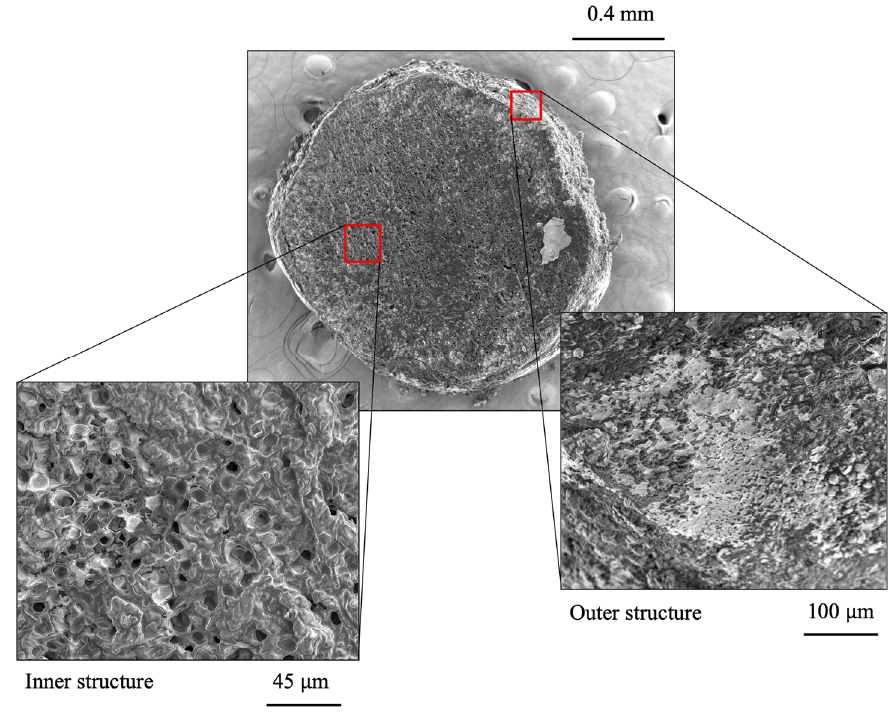
Figure 4. SEM images of the inner and outer structure of a bisected cellular capsule.